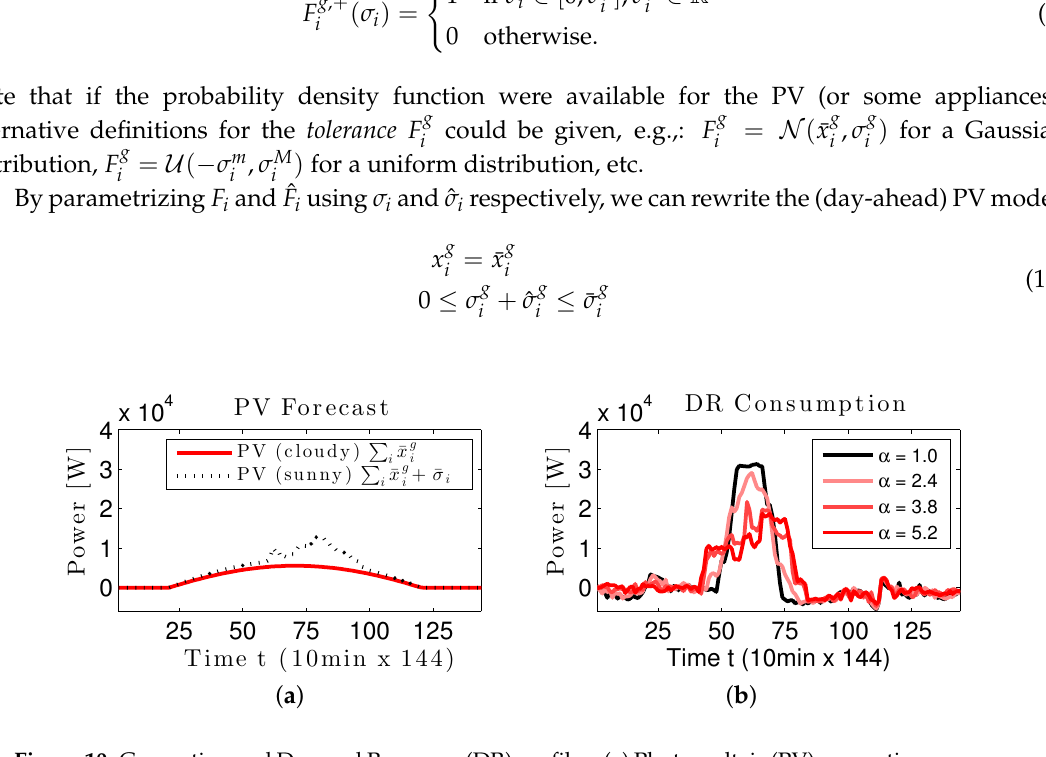
Figure 10. Generation and Demand Response (DR) profiles. ( a ) Photo-voltaic (PV) generation assumes it will be cloudy, but with some possible hours of clear sky; ( b ) Price-based DR total consumption profiles (includes generation, scheduled appliance and managed battery): Each curve is obtained using a different price signal. Note the scale difference with respect to Figure 11a in the y-axis.